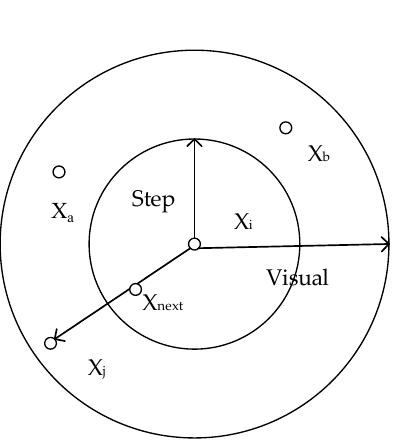
Figure 2. Continuous visual field of artificial fish.